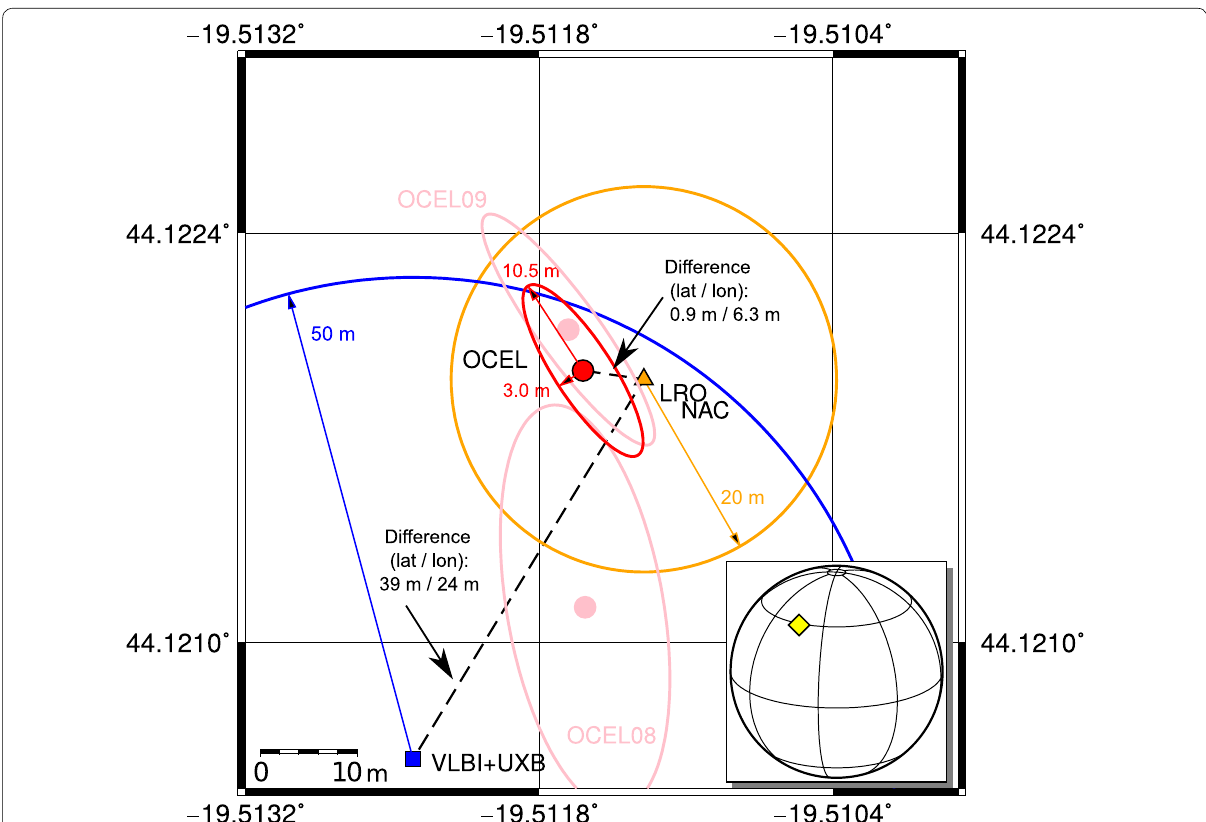
Fig. 3 Comparison of the positions of the CE-3 lander from various studies. The orange triangle refers to the position determined by combining fourteen images taken by the Narrow Angle Camera of the LRO (Liu et al. 2015a). The blue square depicts the coordinates obtained through the use of VLBI and UXB measurements (Li et al. 2014). In both cases, the associated position errors (20 m and 50 m) correspond to the uncertainties stated in Liu et al. (2015a) and Li et al. (2014). The pink dots along with the 1- σ position error ellipses depict the results obtained from the individual OCEL sessions used in this study. The red dot (with the 1- σ error ellipse) represents the weighted mean position of the lander based upon OCEL08 and